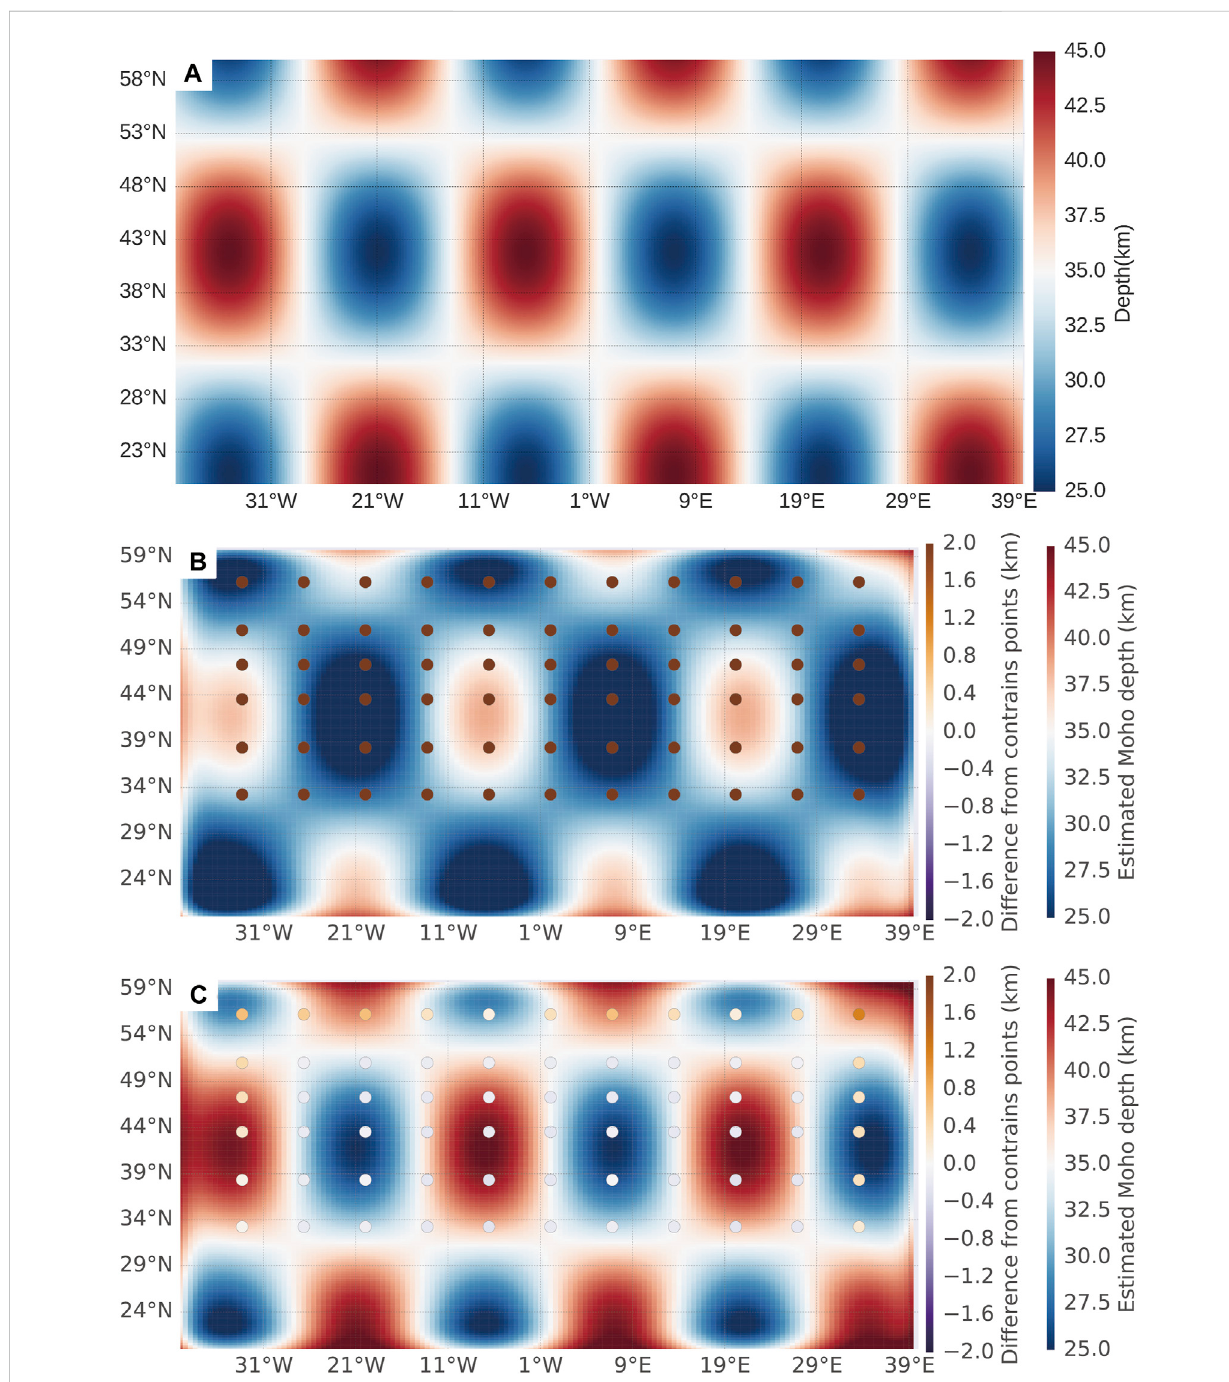
FIGURE 6 Checkboard resolution tests for gravity inversion. (A) Moho depth model. (B) Result of gravity inversion. (C) Result of gravity inversion based on control point constraint (The dots indicate the location of the OBS. The color of the dots indicates the difference between the constrained points value and the inversion